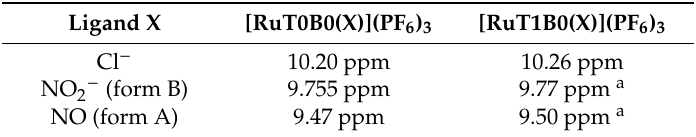
a data from the NMR spectra shown in Figure